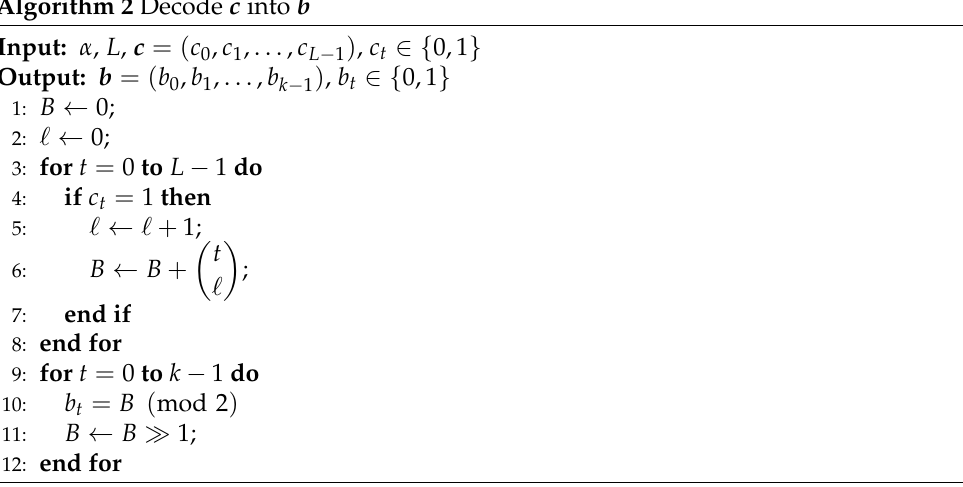
Algorithm 2 Decode c into b